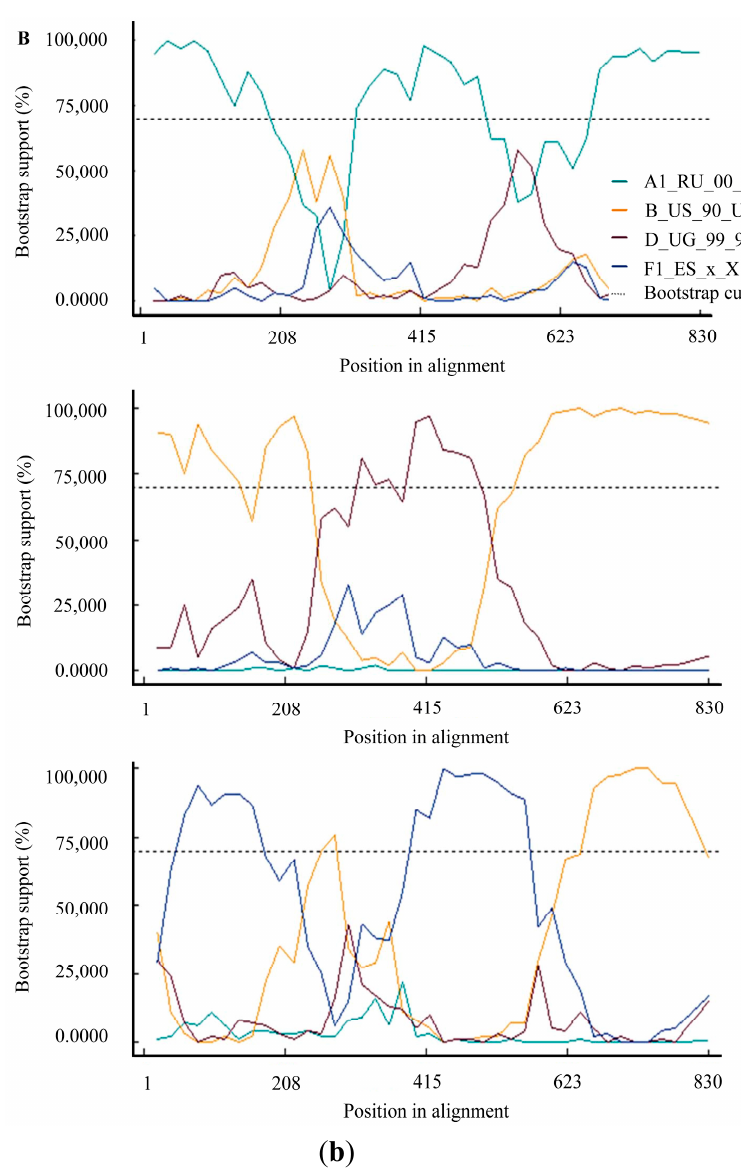
Figure 4. HIV-1 B/D recombination profiles. ( A ) Plots show a graphical representation of the HIV-1 genome showing the genomic region of the query sequence with the start and end positions related to the reference sequence (HXB2) for three examples of recombination profiles. The analyses were performed using REGA (version 3). ( B ) Graphical representation of the breakpoint coordinates as determined by RDP algorithm implemented by Recombination Detection Program v4.61. The reference sequences included were: EU345717, AY173953,